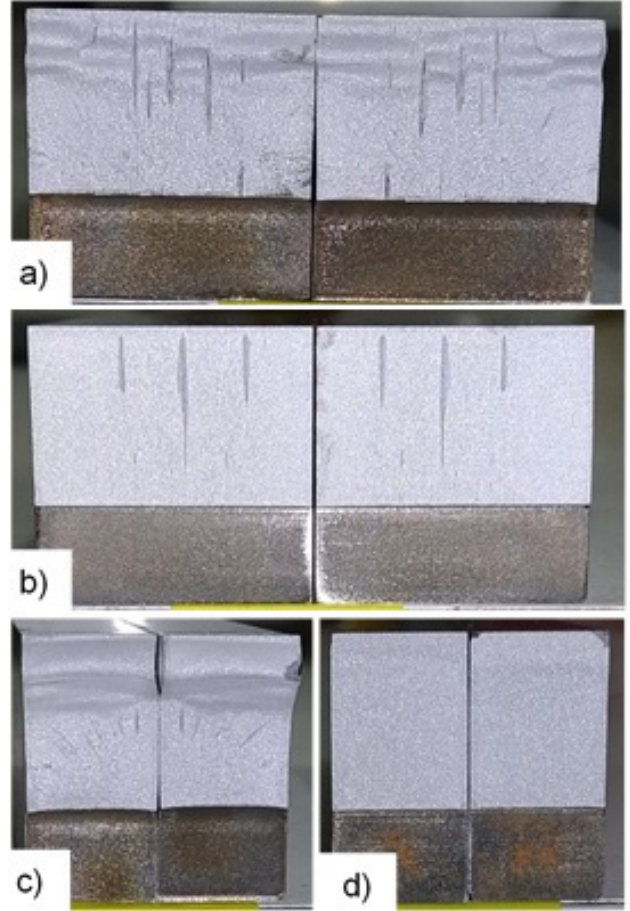
Figure 9. Fracture surface: (a) thickness of 14 mm and radius of 1 mm, (b) thickness of 14 mm and radius of 0.17 mm, (c) thickness of 7 mm and radius of 1 mm, and (d) thickness of 7 mm and radius of 0.17